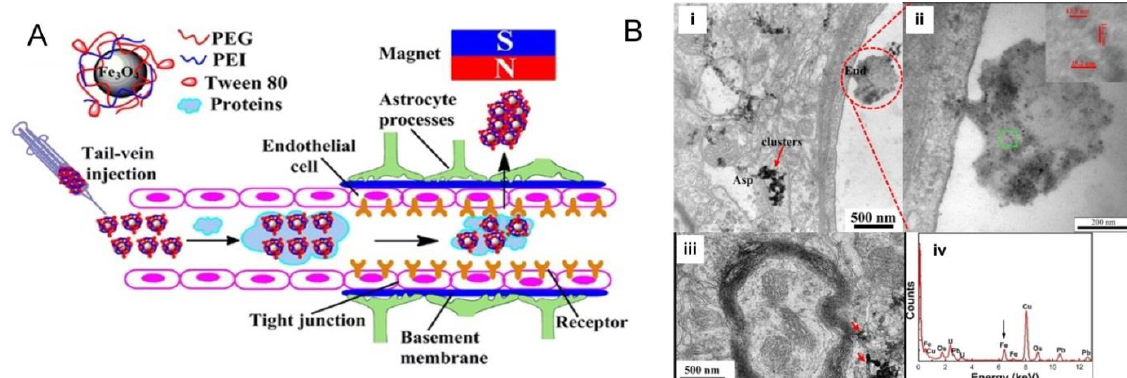
Figure 8. ( A ) PS-coated superparamagnetic iron oxide NPs (PS-SPIONs) pass through the intact BBB in rats under magnetic field. ( B ) Intracellular distribution of the PS-SPIONs in the frontal cortex in the presence of EMF. (i, ii) TEM images of PS-SPIONs that enter the brain by crossing BBB. (iii) Nanoparticle clusters were found near the axons of neurons. (iv) EDS analysis of electron-dense black clusters indicates the presence of Fe. Reproduced with permission from Reference [137]. Copyright 2016, American Chemical Society.